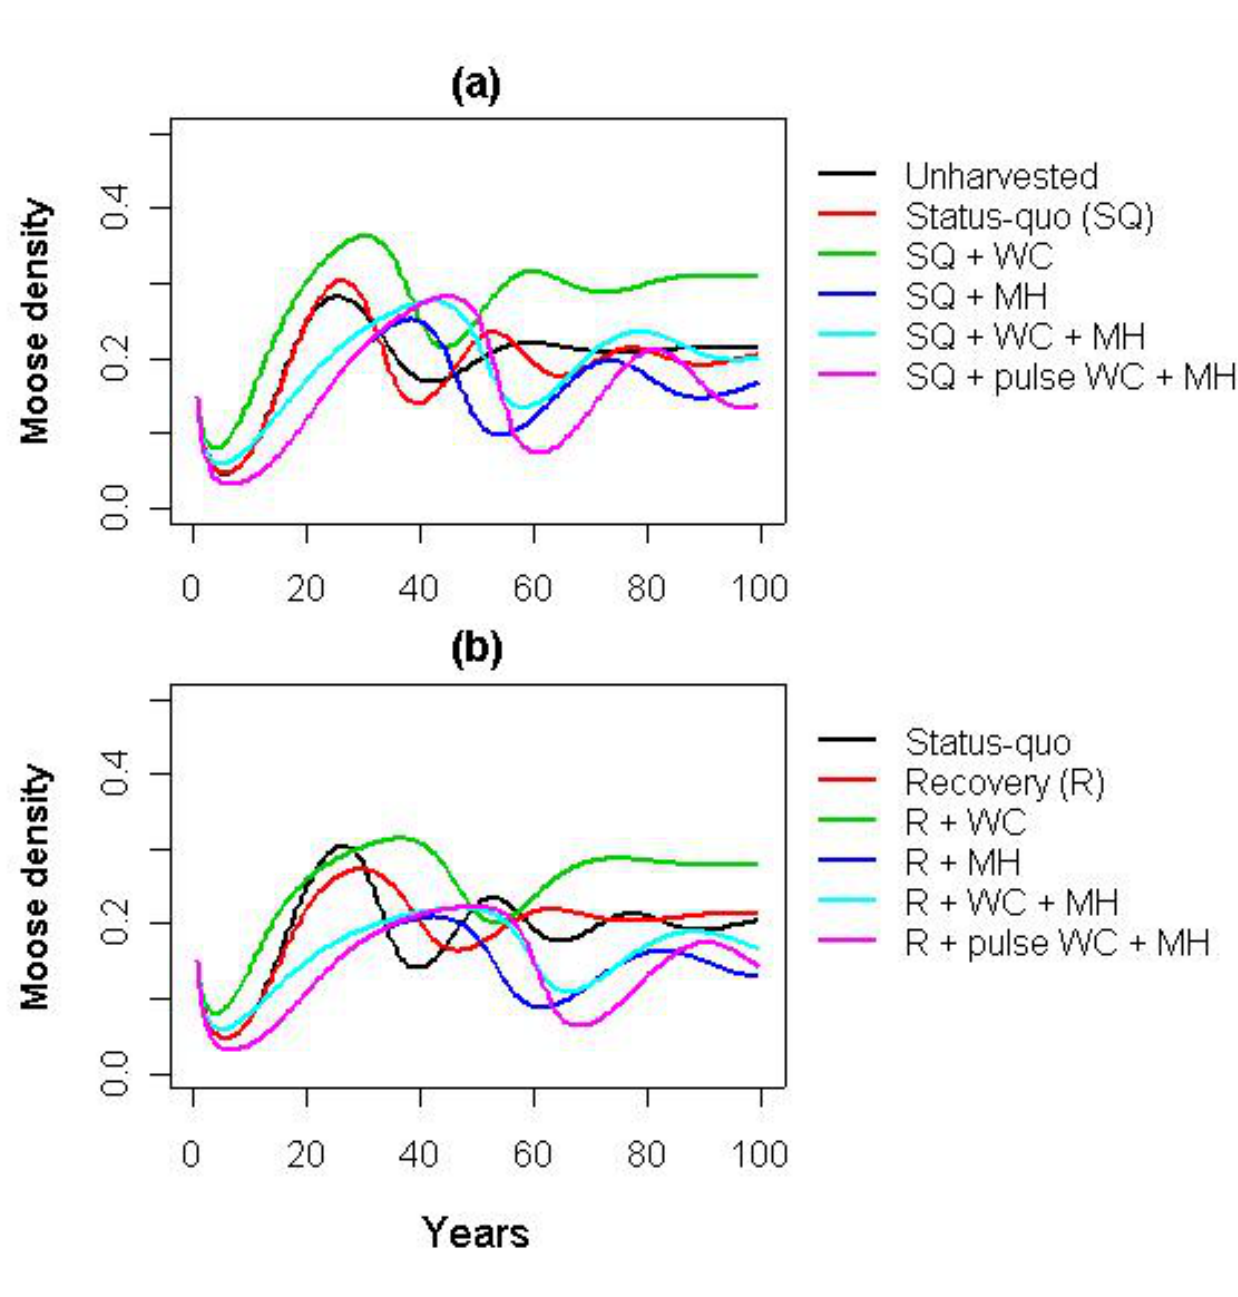
Fig. 5. Predicted moose densities (animals km 2 ) under alternative management options. Recovery refers to a 15% reduction in forest harvest. WC = Wolf control; MH = Moose harvest; Pulse WC = 10-year timed wolf